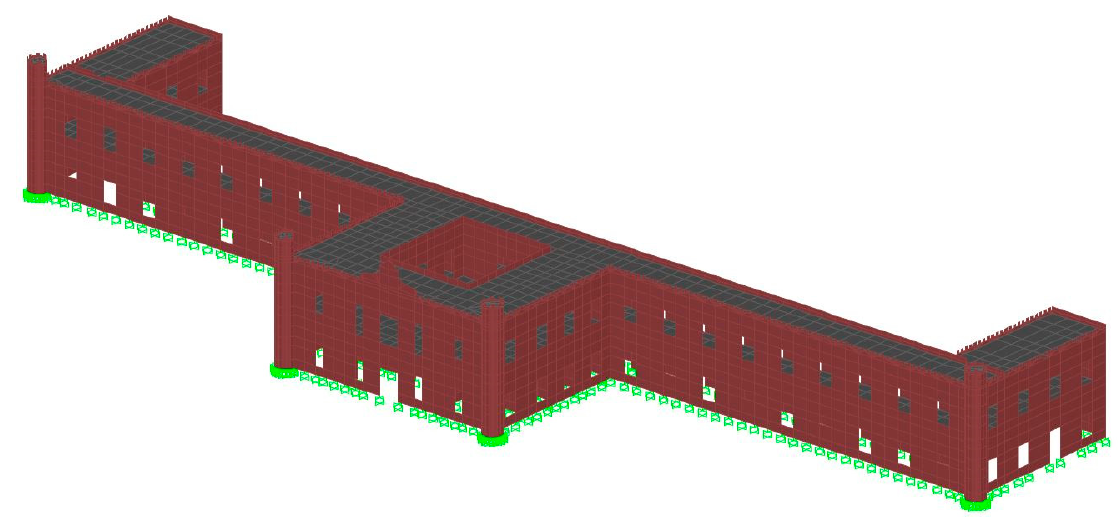
Figure 8. Finite elements model (tridimensional lateral view) [12].